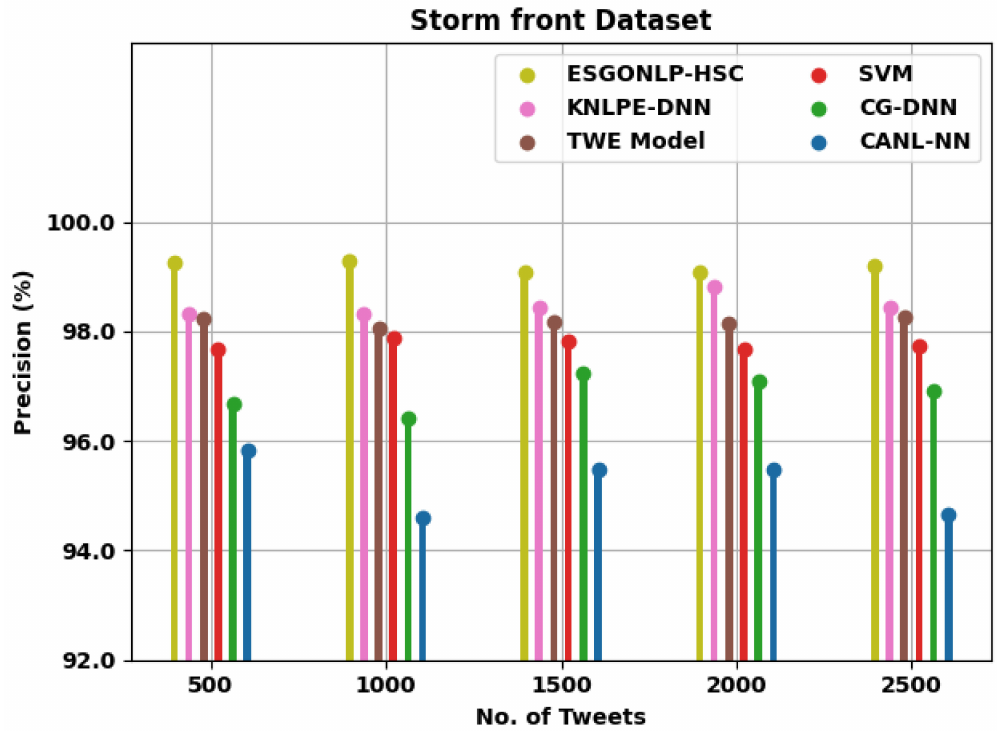
Figure 5. Prec n analysis of ESGONLP-HSC technique under Storm front